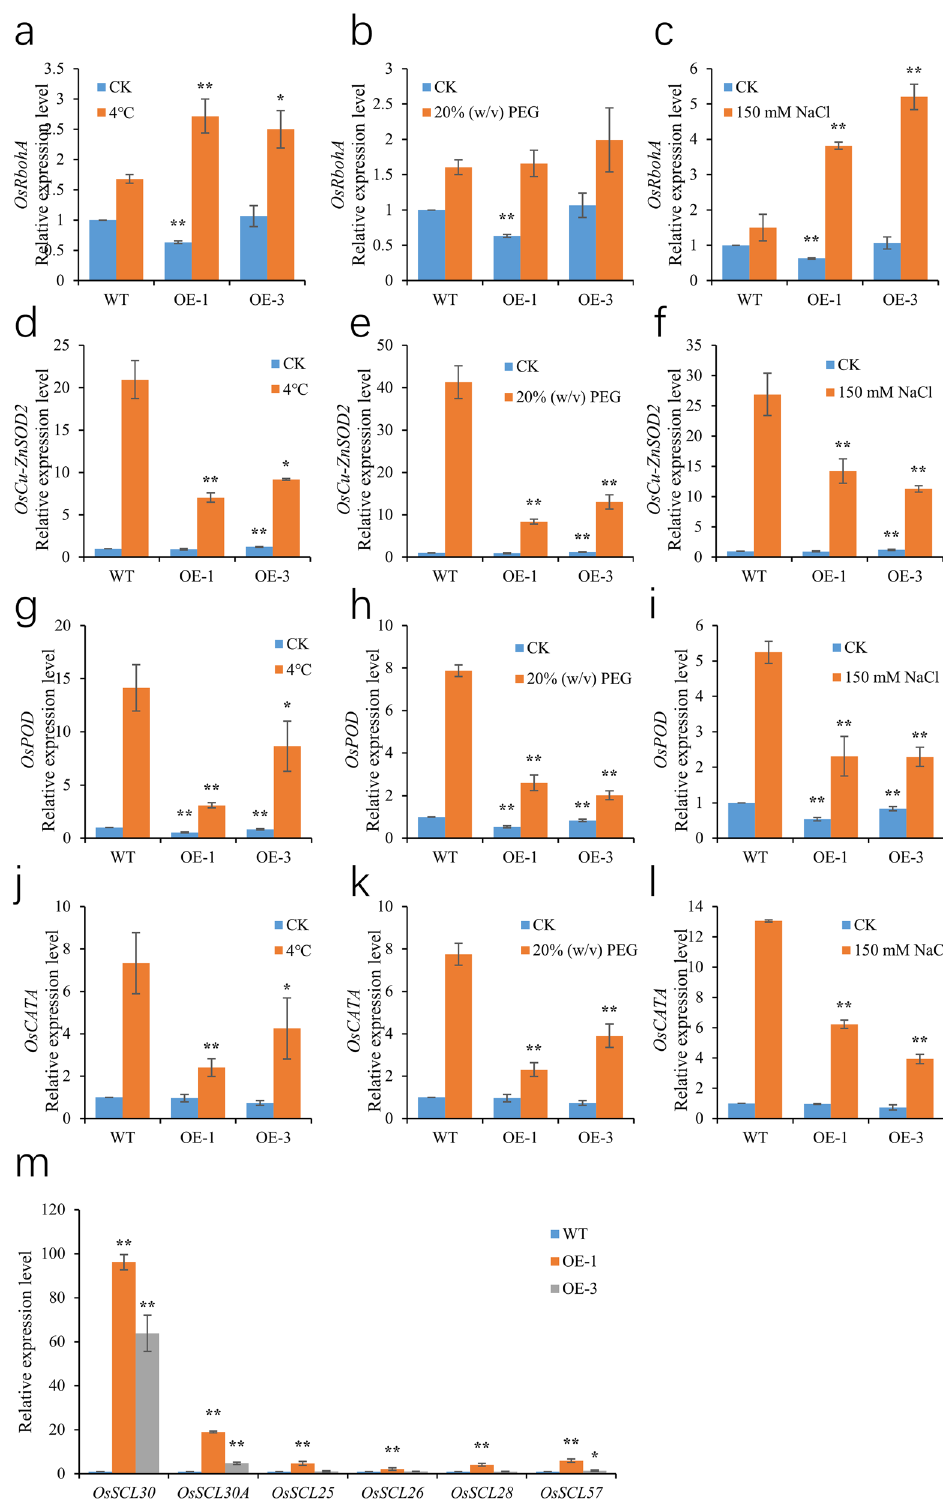
Figure 7. ( a - l ) Expression of ROS production and clearance related genes in WT and OsSCL30-OE plants. ( a – c ) Expression of OsRbohA in WT and OsSCL30-OE plants are treated with or without 4 °C, 20% w/v PEG and 150 mM NaCl for 2 days. ( d – f ) Expression of OsCu-ZnSOD2 in WT and OsSCL30-OE plants are treated with or without 4 °C, 20% w/v PEG and 150 mM NaCl for 2 days. ( g – i ) Expression of OsPOD in WT and OsSCL30-OE plants are treated with or without 4 °C, 20% w/v PEG and 150 mM NaCl for 2 days. ( j – l ) Expression of OsCATA in WT and OsSCL30-OE plants are treated with or without 4 °C, 20% w/v PEG and 150 mM NaCl for 2 days. (m) Expression of SCL subfamily related genes in WT and OsSCL30-OE plants. Error bars represent ± SE (n = 3). Asterisks indicate significant differences between transgenic lines and WT ( * P < 0.05, ** P <